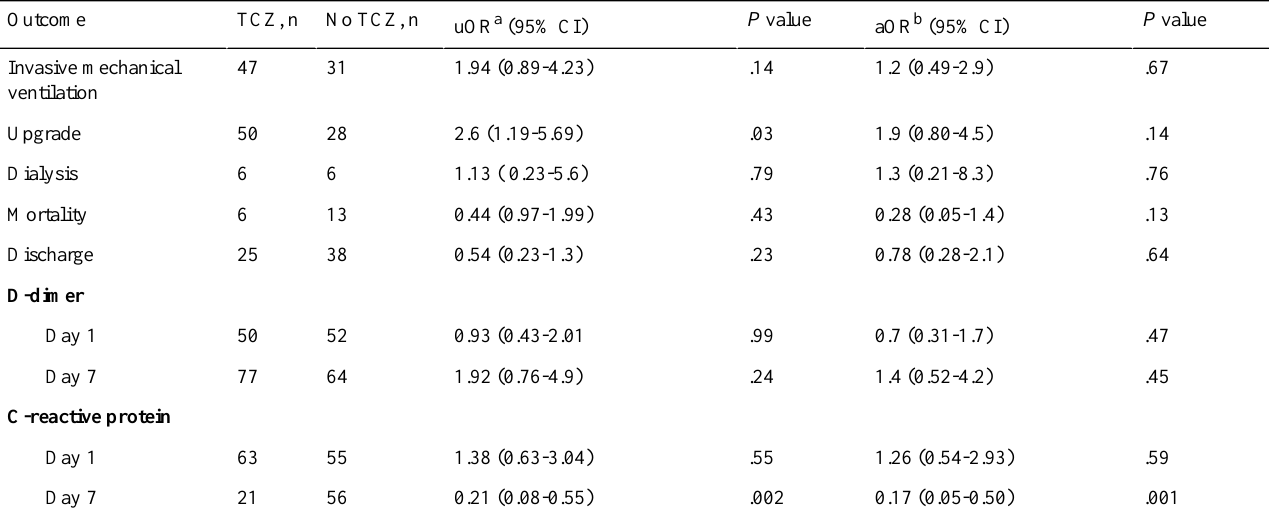
Table 2. Tocilizumab (TCZ) regression analysis with outcome.